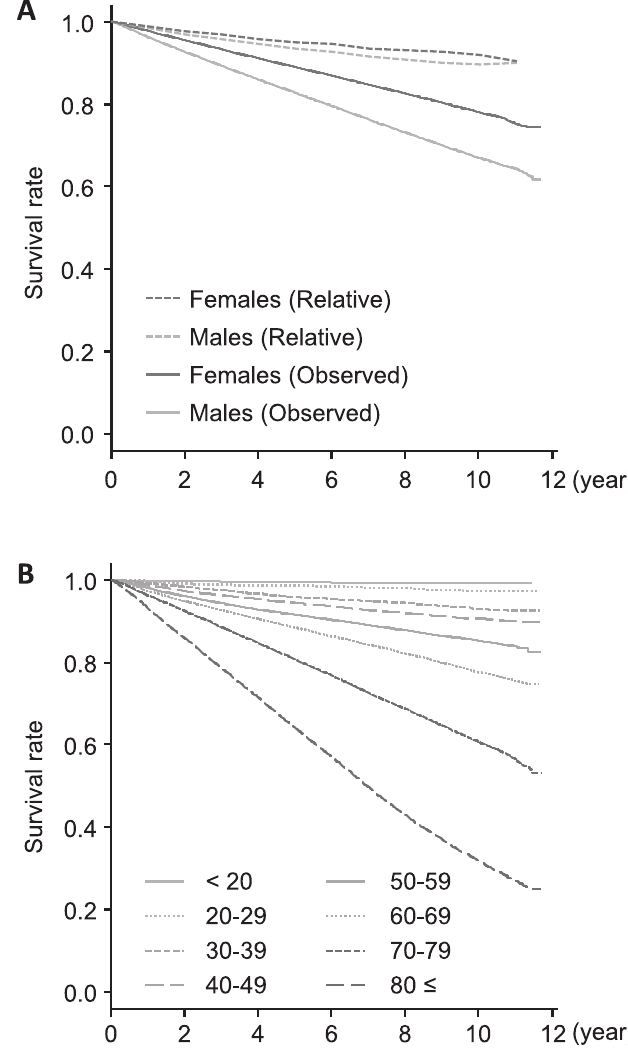
Fig.1. Survival curves of all subjects based on sex and age group classi fi cation. (A) Observed cumulative survival curves (solid) were analyzed by Kaplan e Meier methods. Relative survival rates (dotted) were estimated as the ratio of the observed cumulative survival rates of subjects to the expected survival rates, based on a survival-rate table of general Japanese population from the Cancer Registry and Statistics, Cancer Infor- mation Service, National Cancer Center, Japan. (B) Observed cumulative survival rates of all subjects by age-groups were analyzed by Kaplan e Meier methods. Categorization of age groups was performed according to age at